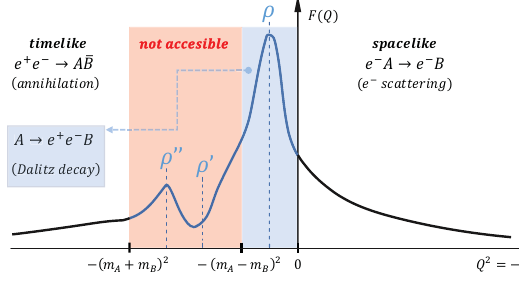
Figure 3. A schematic view of etFF evolution as a function of q 2 and kinematic conditions relevant for experiments in timelike and spacelike